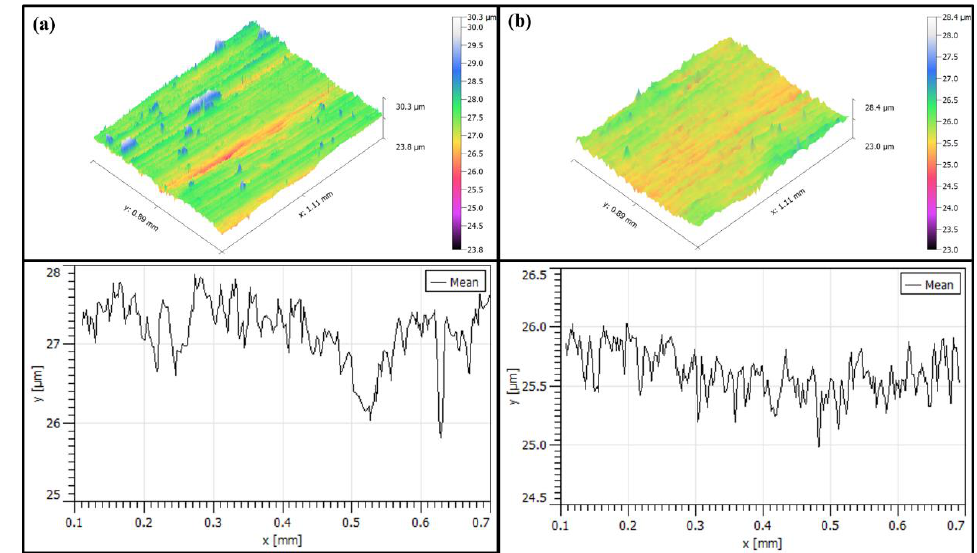
Figure 15. ( a ) Shows the surface of test 2, ( b ) shows the surface of test 4.